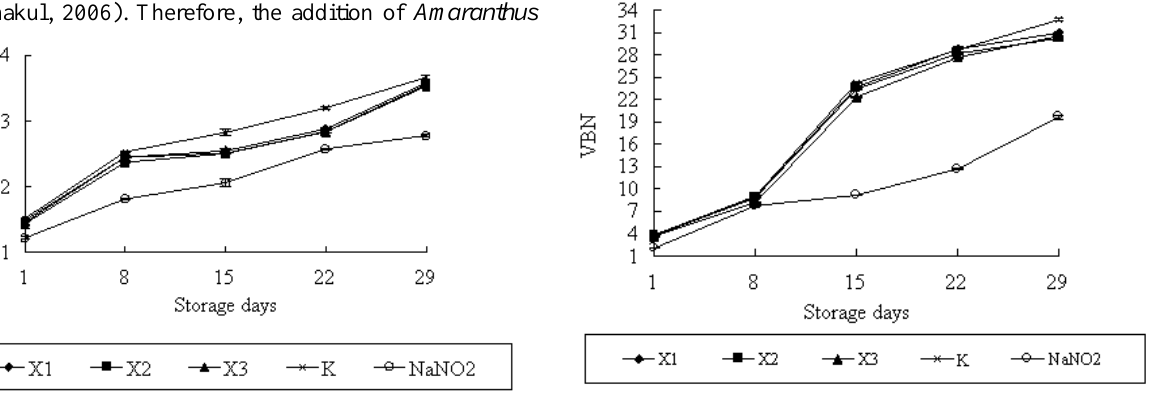
Figure 2. The changes in TBA of pork sausages. TBA: mg malonaldehyde/kg sample. X1, X2 and X3 stand for the samples with 0.1%, 0.2% and 0.3% Amaranthus pigments addition, respectively; K stands for the controls; NaNO 2 stands for the samples with 0.015% NaNO 2 addition.